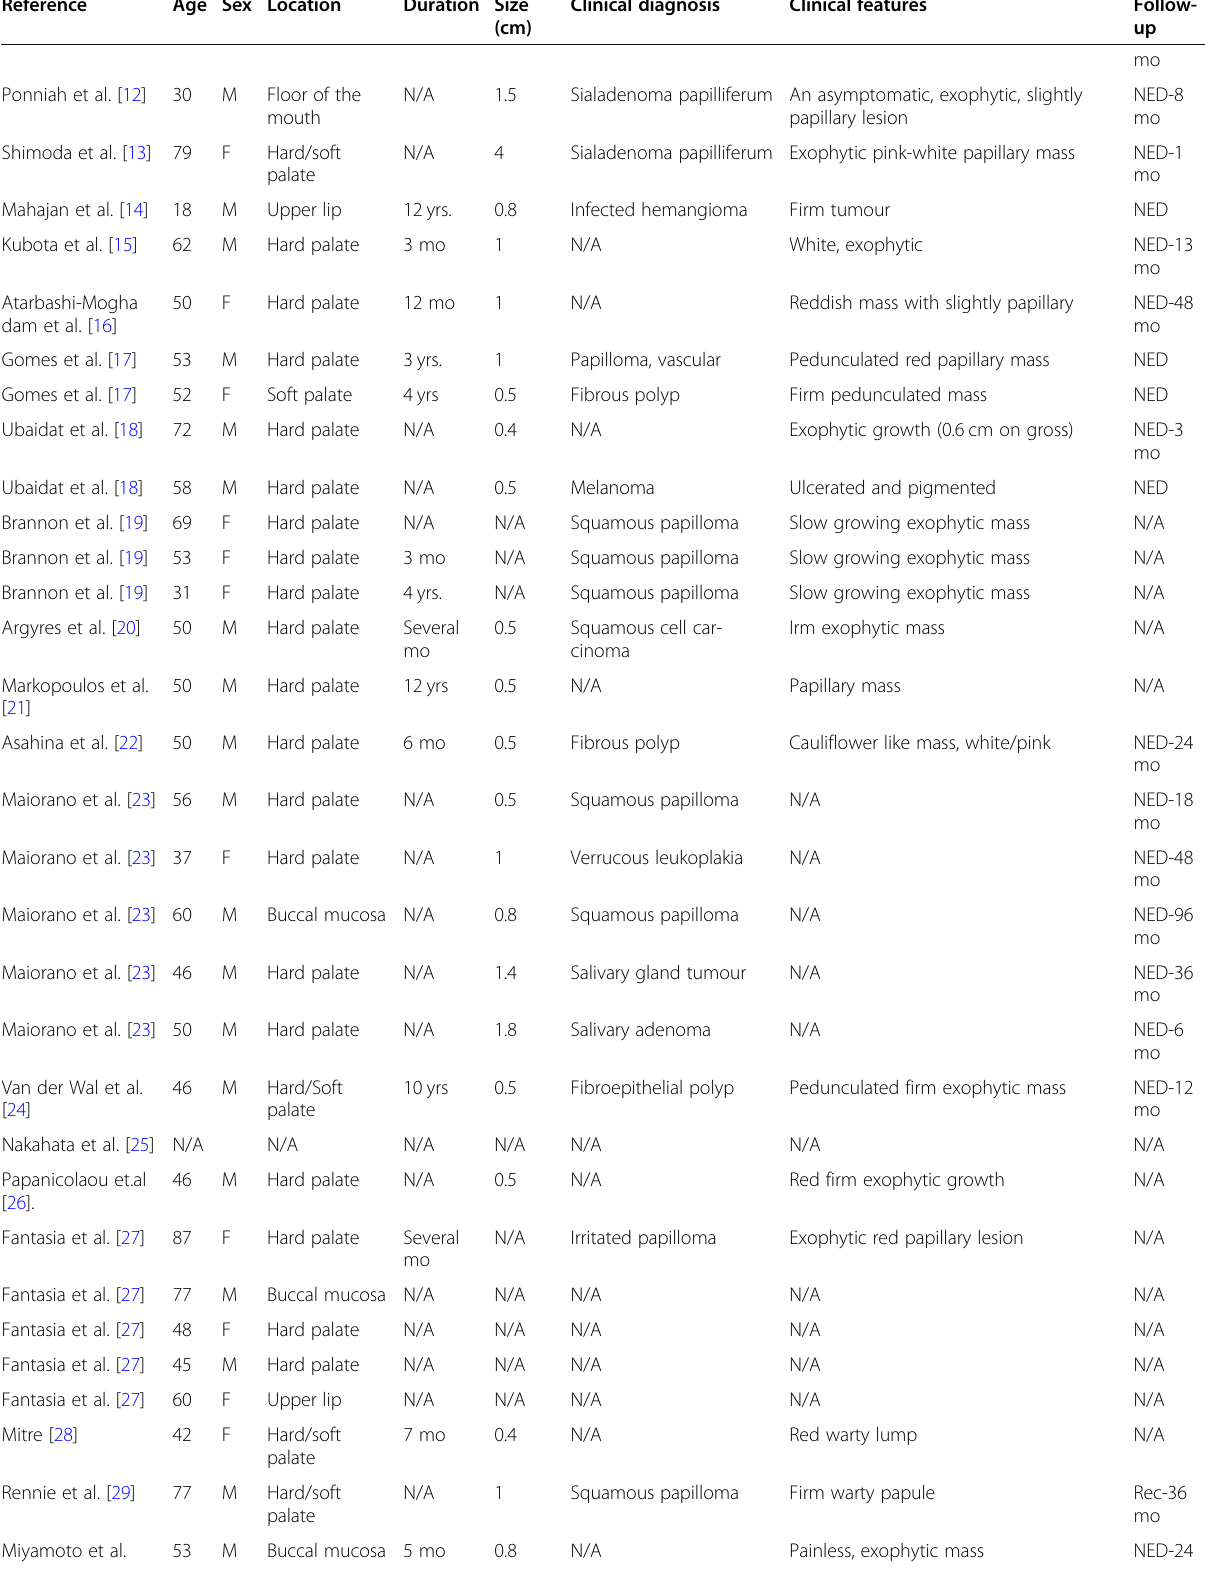
Table 1 Clinical features of sialadenoma papilliferum (95 cases, but 94 cases available) (Continued)